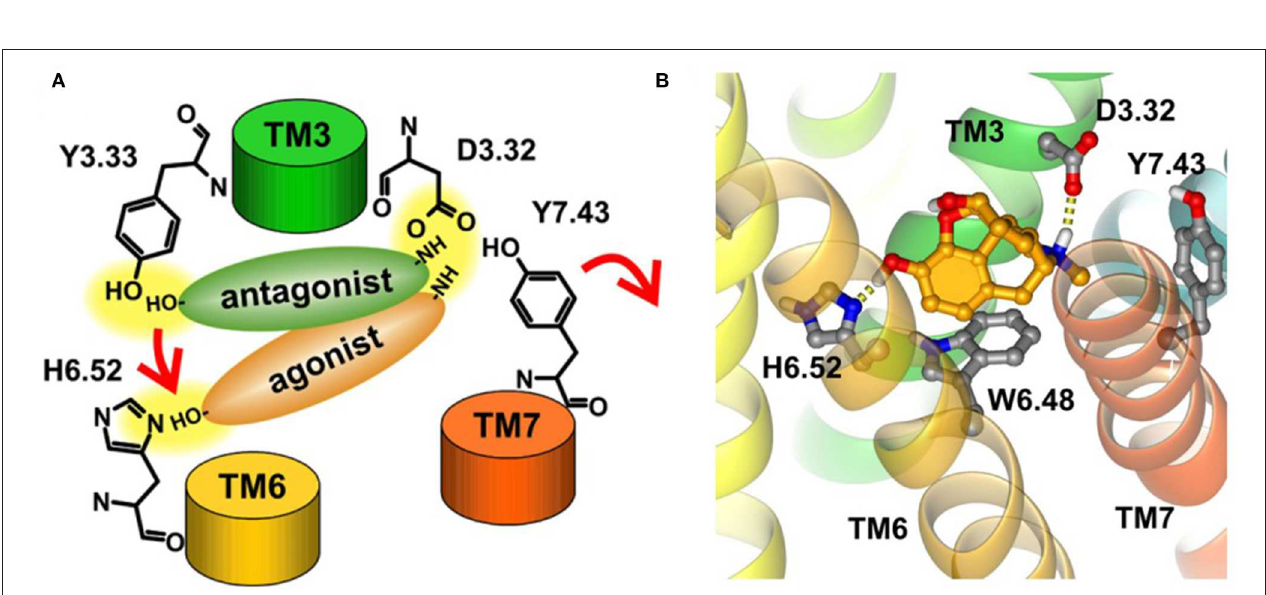
FIGURE 6 | Binding structures of DOR-6j and DOR-SIOM obtained from molecular docking. (A) The binding mode of (–)-6j (colored in orange) at the agonist binding site of DOR. (B) The binding mode of SIOM (cyan color) at the DOR binding site. Important interactions are shown by black dotted lines.